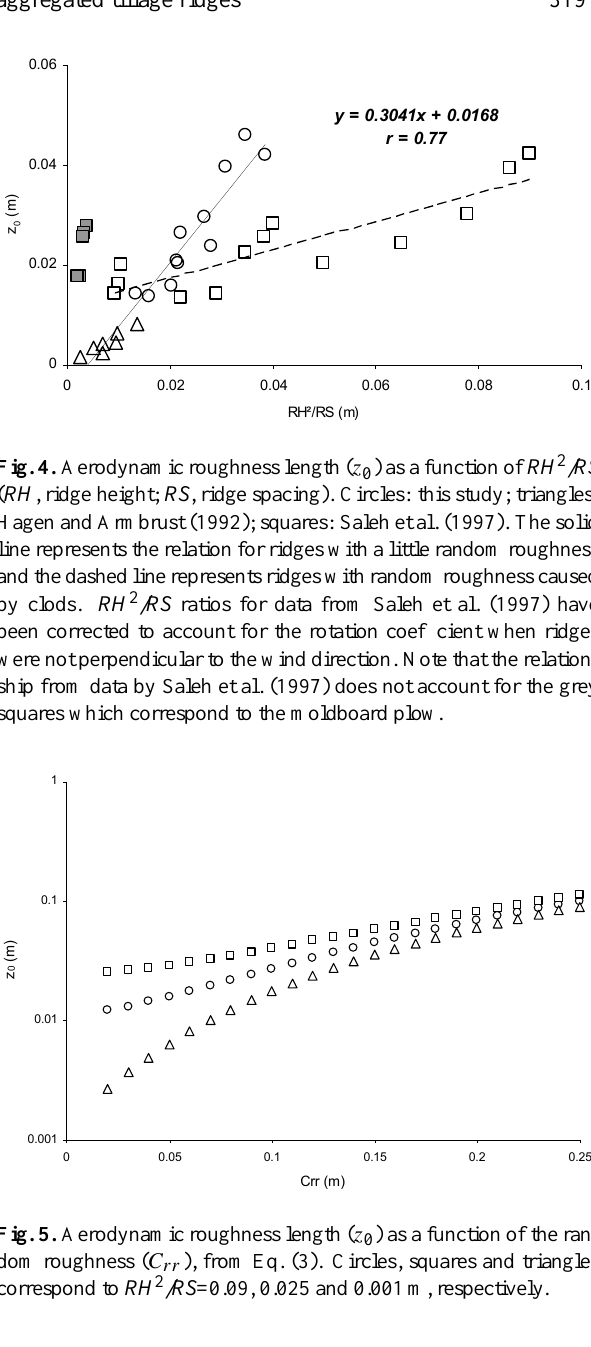
slope of the regression differed significantly from that of the Eq.